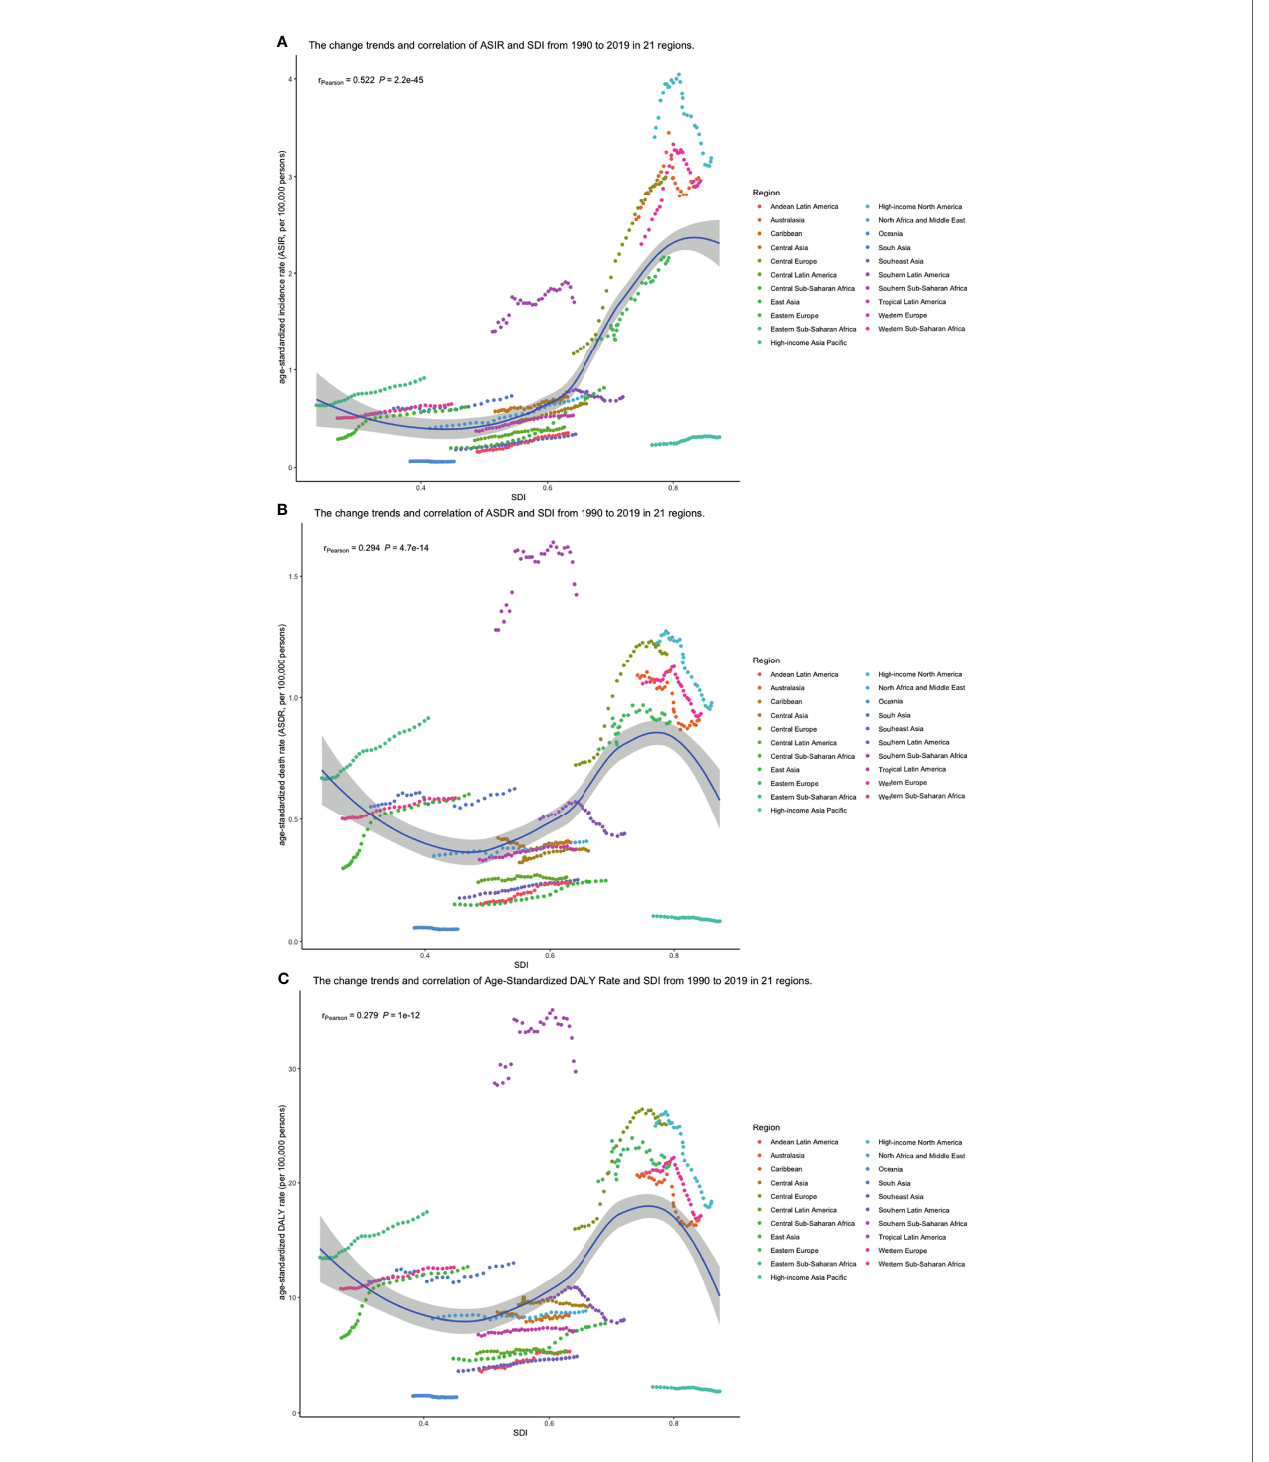
FIGURE 11 | The change trend and correlation between (A) ASIR, (B) ASDRs, and (C) age-standardized DALY rates and SDI from 1990 to 2019. The color of circle represents the 21 different regions. (ASIR, age-standardized incidence rate; ASDR, age-standardized death rate; DALY, disability-adjusted life year; SDI, socio- demographic index; SDI, socio-demographic